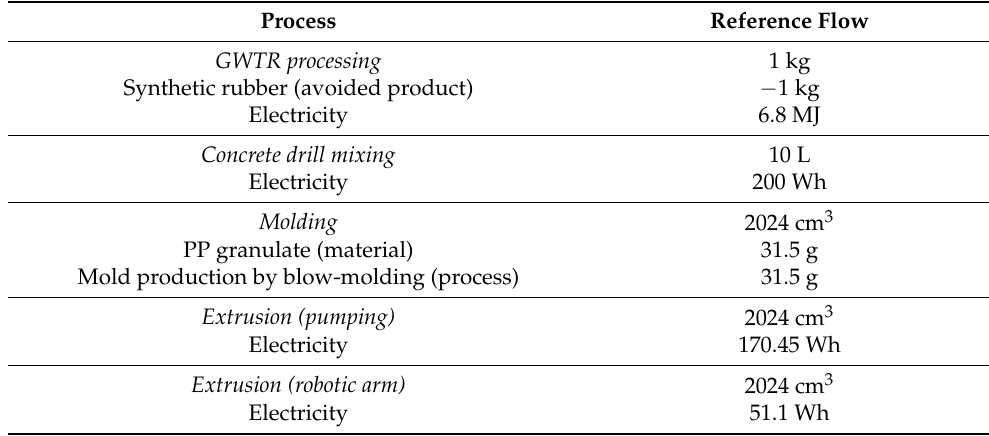
Table 4. Inventory of the processes defined in this work and not present in the SimaPro